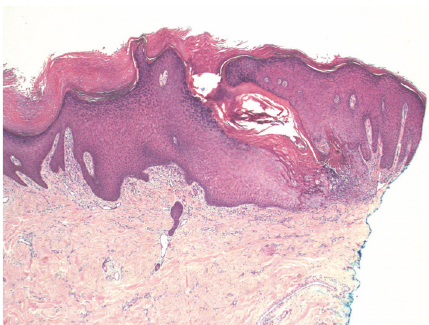
Figure 1: Dorsum of left knee. Figure 3: Higher magnification showing the area of defect con- taining neutrophils, parakeratosis, and degenerating keratinocytes (hematoxylin and eosin stain, original magnification × 200).